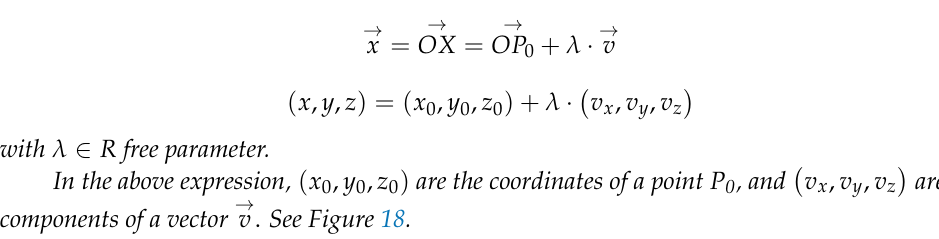
Figure 18. Geometric interpretation of the line equation in vector form ( ) 2 λ= − .